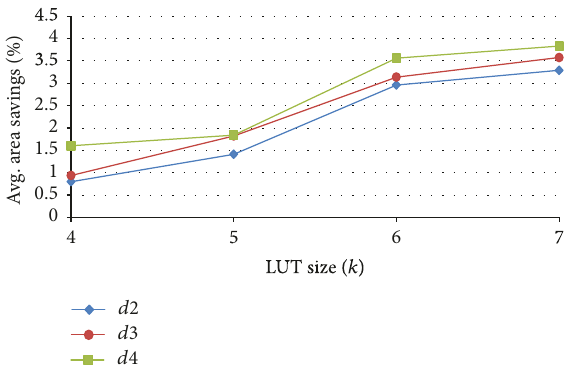
Figure 13: Average area savings for 𝑁 = 16 , 𝑘 = 4–7, and 𝑑 = 2–4 over the 20 MCNC benchmark circuits.